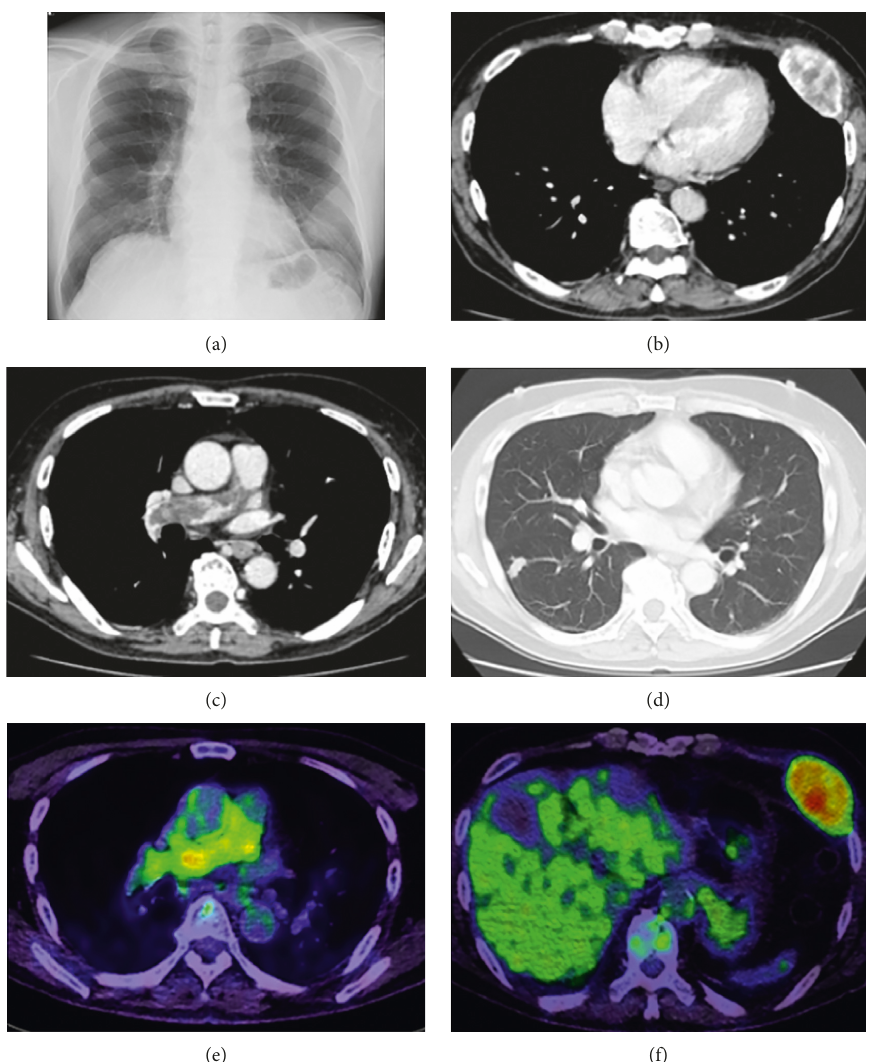
Figure 1: Radiological examinations at diagnosis. A chest radiograph showed a faint infiltrative shadow in the left lower lung field (a). Contrast medium-enhanced chest computed tomography showed a large tumor in the left anterior chest wall (b). An enhanced mass in the right pulmonary artery (c) and small nodules in the right lung (d) were also found. Fluorodeoxyglucose (FDG)-positron emission to- mography revealed positive FDG uptake in the pulmonary artery mass (e) and in the chest wall tumor